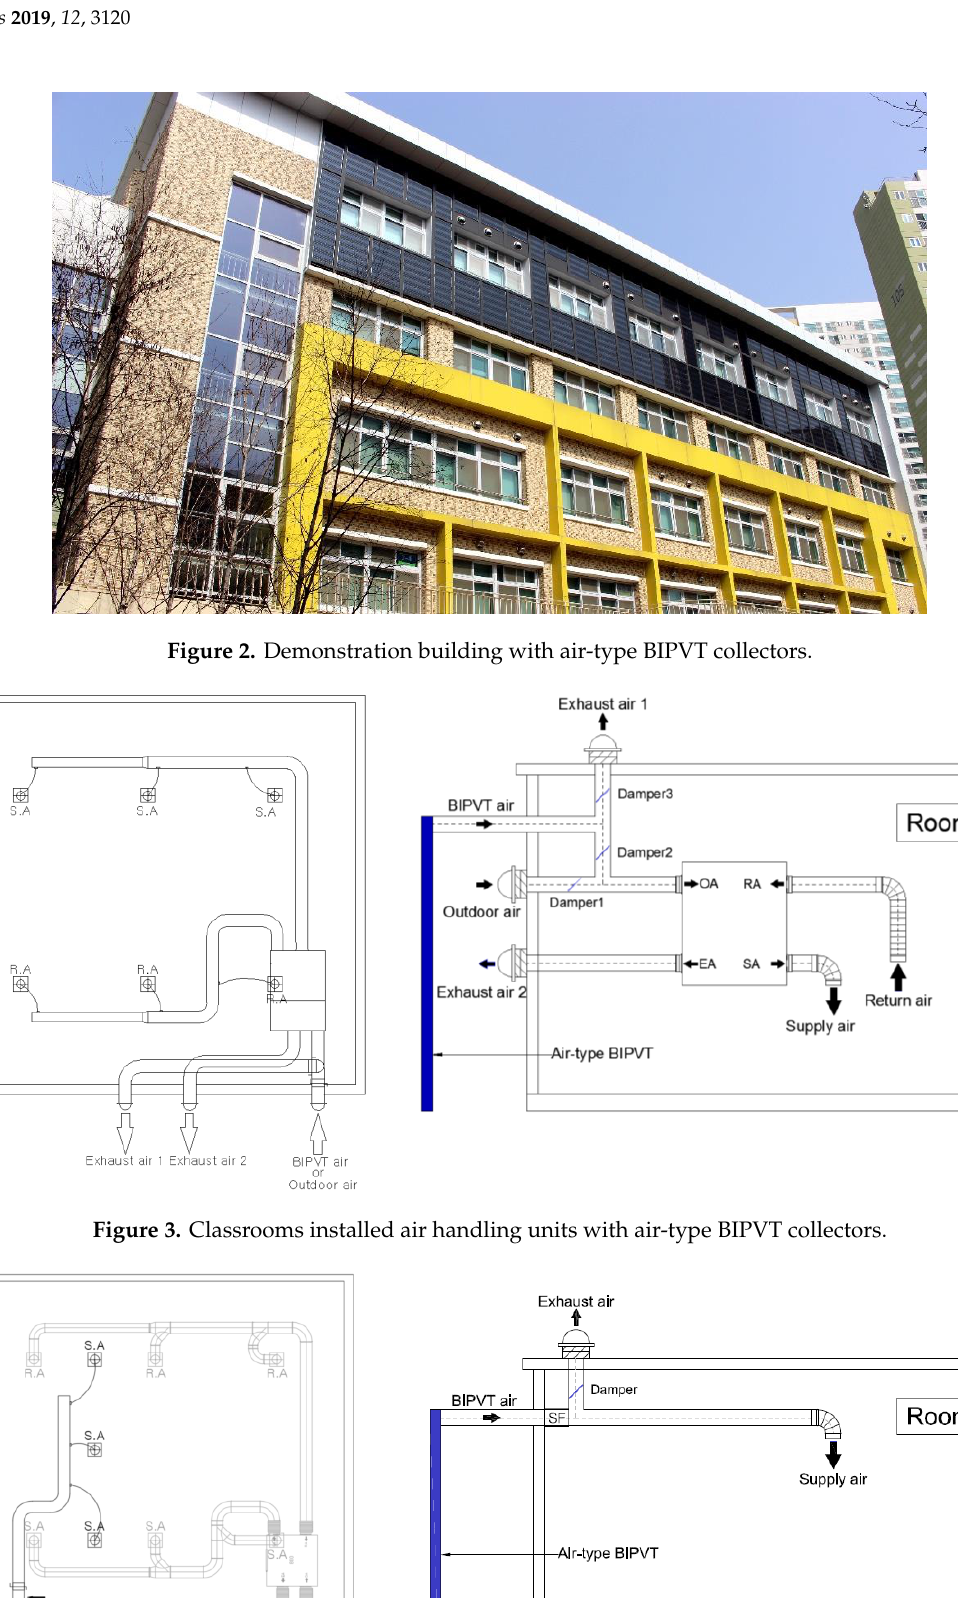
Figure 1. Air-type building integrated photovoltaic/thermal (BIPVT) collector on the demonstration building.